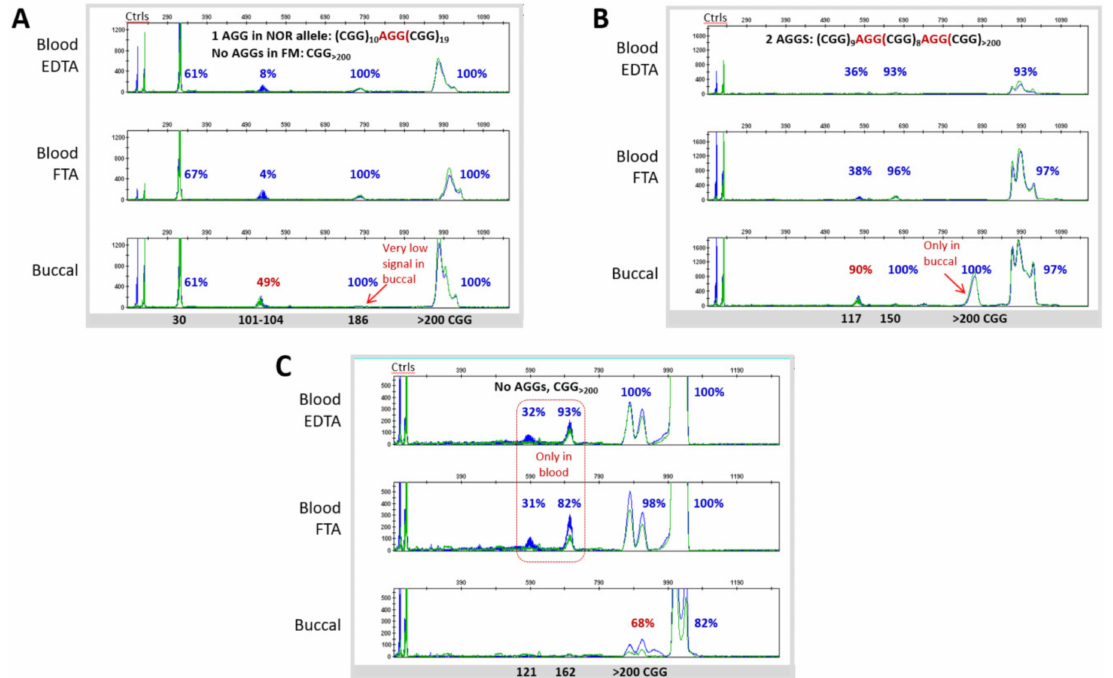
Figure 4. Level of concordance in primary allele CGG sizing and methylation status in blood and buccal specimen from subjects with FXS. ( A ) Female with FXS (sample 04) with PM size mosaicism and di ff erential relative methylation in blood and buccal gDNA. ( B ) Male with FXS (sample 06) with an additional FM peak in buccal cells compared to blood, along with methylation mosaicism. ( C ) Male with FXS (sample 15) with a blood-only PM size mosaicism and reduced relative methylation of the FM in the buccal sample. Capillary electrophoresis traces show CGG repeat length (blue, undigested) and methylation status (green,